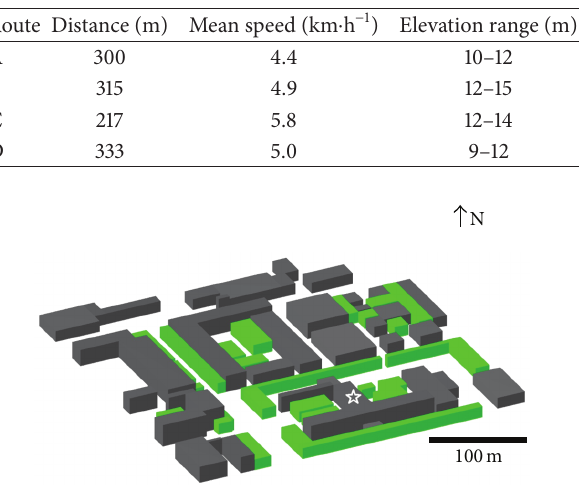
Figure 2: Computational domain generated by VADIS for the set of buildings (in grey) and trees (in green). The star indicates the location of the school.